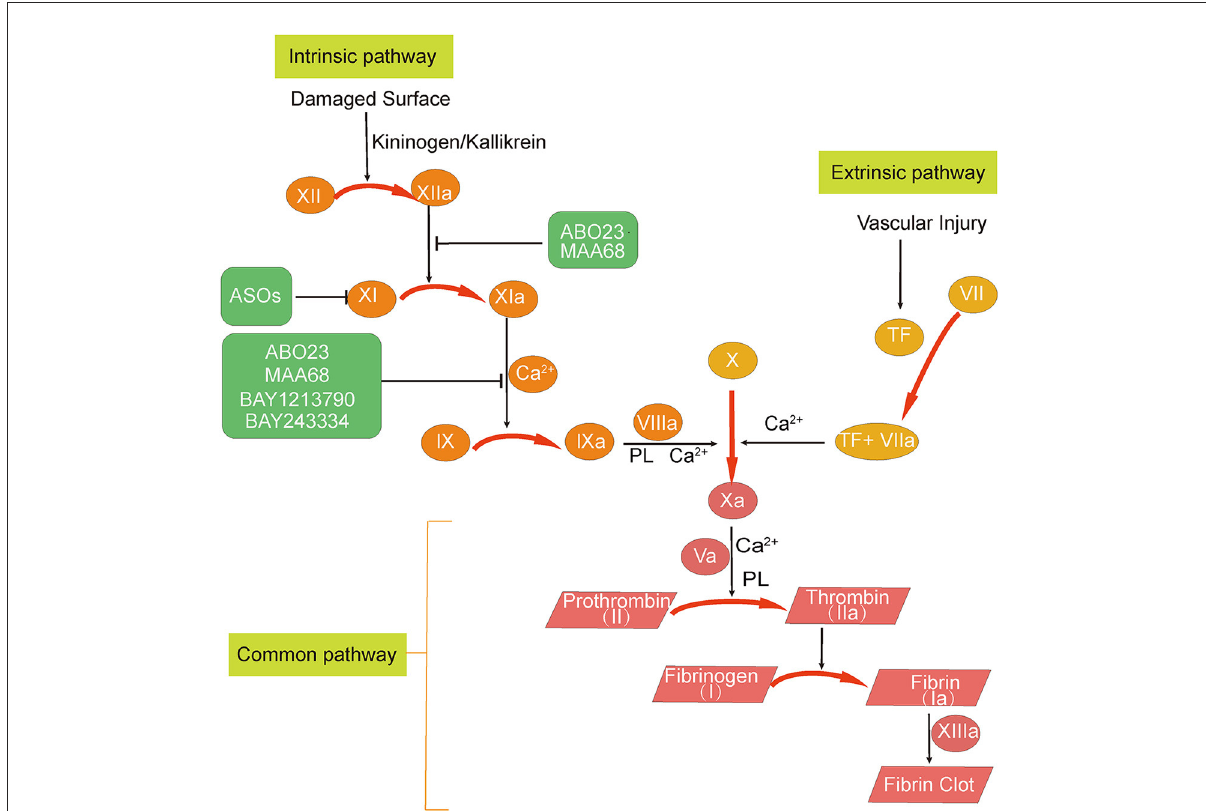
FIGURE1 Overview of the sites of action of factor XI (FXI)/activated factor XI (FXIa) inhibitors. The three FXI inhibition strategies can be summarized as follows: (1) degradation of FXI mRNA; (2) inhibition of FXI activation to FXIa; and (3) inhibition of FXIa activity. Abelacimab (MAA868) and osocimab (BAY1213790) are antibodies that inhibit FXIa activity. Abelacimab can also inhibit the activation of FXI by activated factor XII (FXIIa). IONIS-FXIRx and FXI-LICA are antisense oligonucleotides (ASOs) that promote FXI mRNA degradation in the liver and reduce the amount of